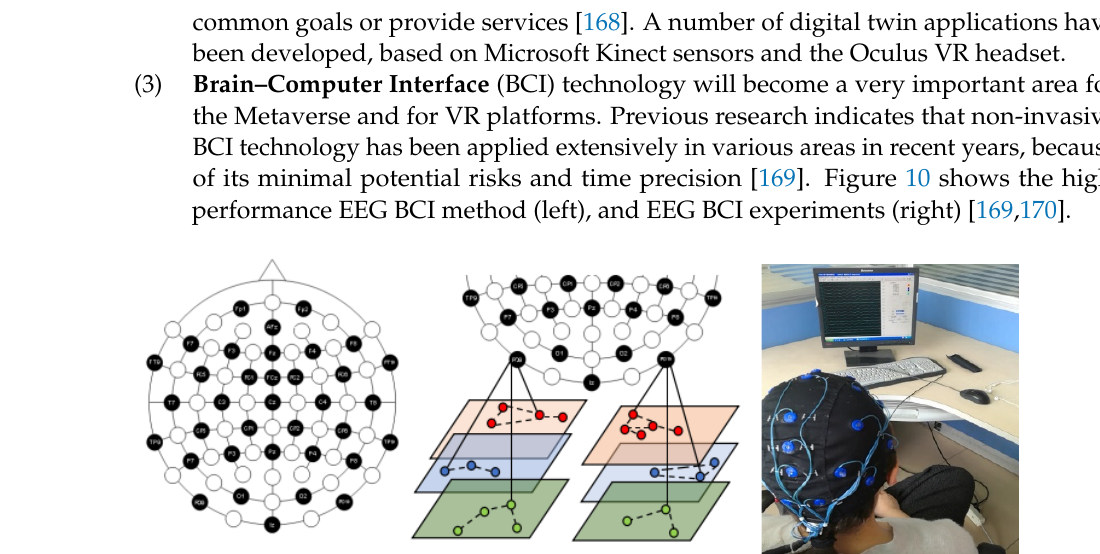
Figure 10. Segmented EEG time window (left), source: [169]; EEG experiment (right), source: [170].